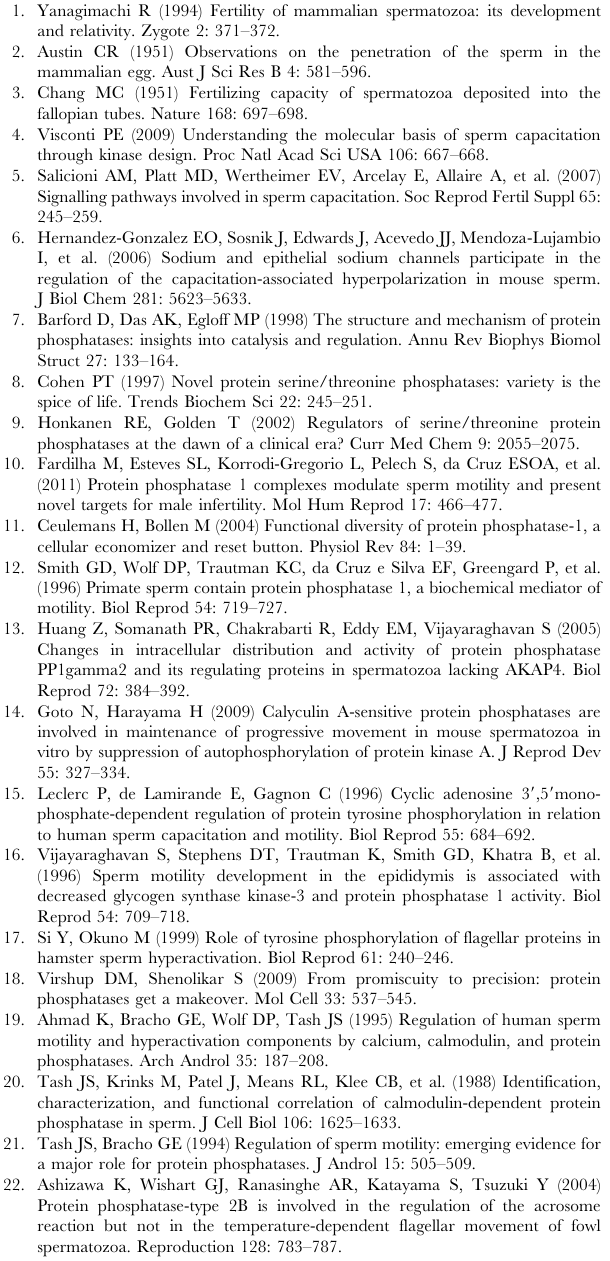
Figure S4 Effects of endothall and dimethylendothall (DME) on the capacitation of human sperm. Sperm resuspended in CM were treated with different concentrations of endothall and with 90 nM DME. The percent of capacitated cells was evaluated at various times. Results were obtained from five different donors and are expressed as the mean 6 SEM of the percentage of the B pattern. *** p ,